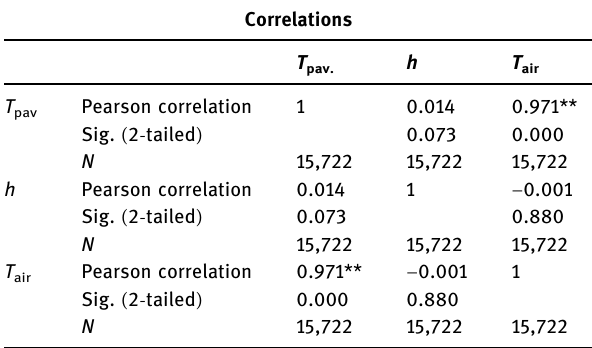
Table 3: Correlation matrix between dependent and independent variables